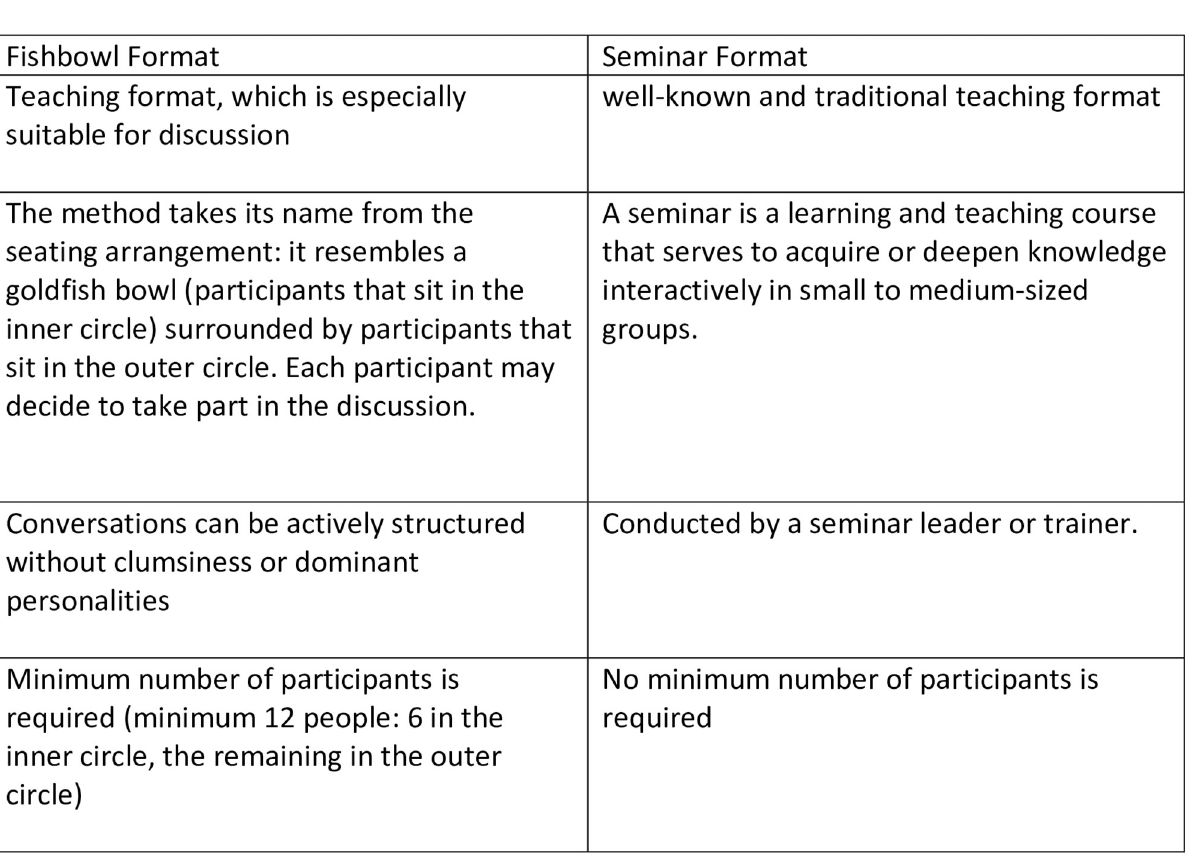
Fig 2. The important differences between the fishbowl and seminar